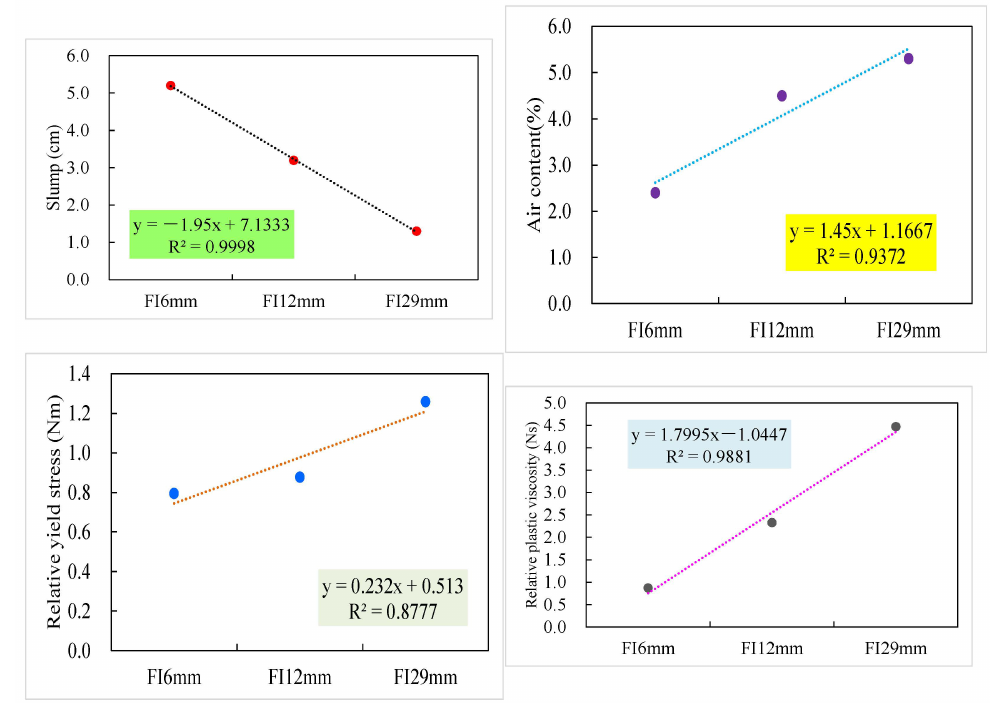
Figure 8. Effect of fiber on slump, air content, relative yield stress, and viscosity.